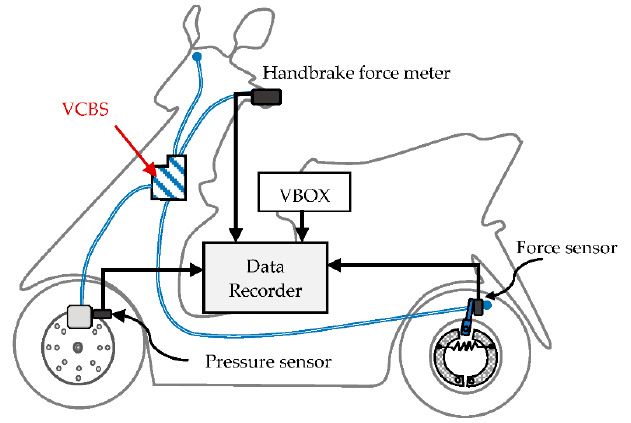
Figure 12. The layout of the VCBS prototype and the associated measurement system. left handlever force, brake triggering speed, MFDD (Mean Fully Developed Deceleration) [22,23], and braking distance. The test results show that, with the averaged maximum the homologation requirement of 5.1 m/s 2 (0.52 g). Table 2. Brake distance and deceleration at laden load.